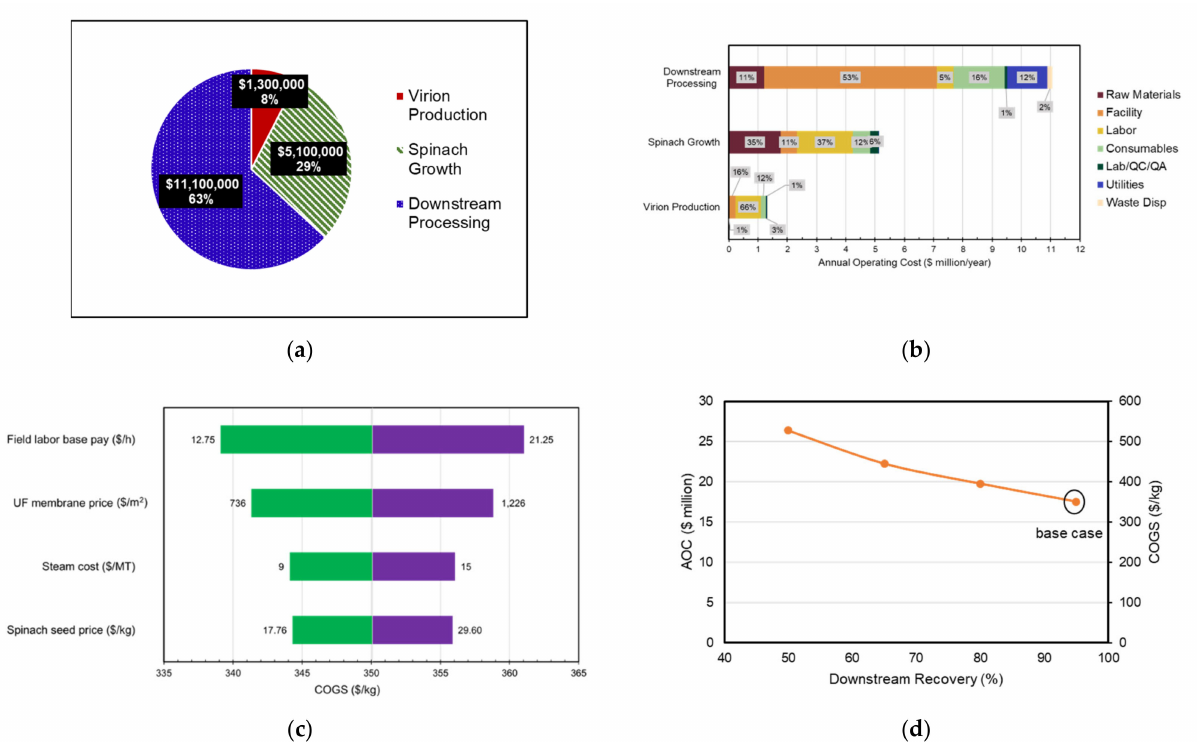
Figure 5. Spinach made annual operating cost breakdown ( a ) per facility section ( b ) section’s category. ( c ) Tornado analysis for facility’s top cost drivers. ( d ) Effect of varying downstream recovery on AOC assuming a constant target production level of 50 MT/year. AOC, annual operating costs; COGS, cost of goods sold; MT, metric